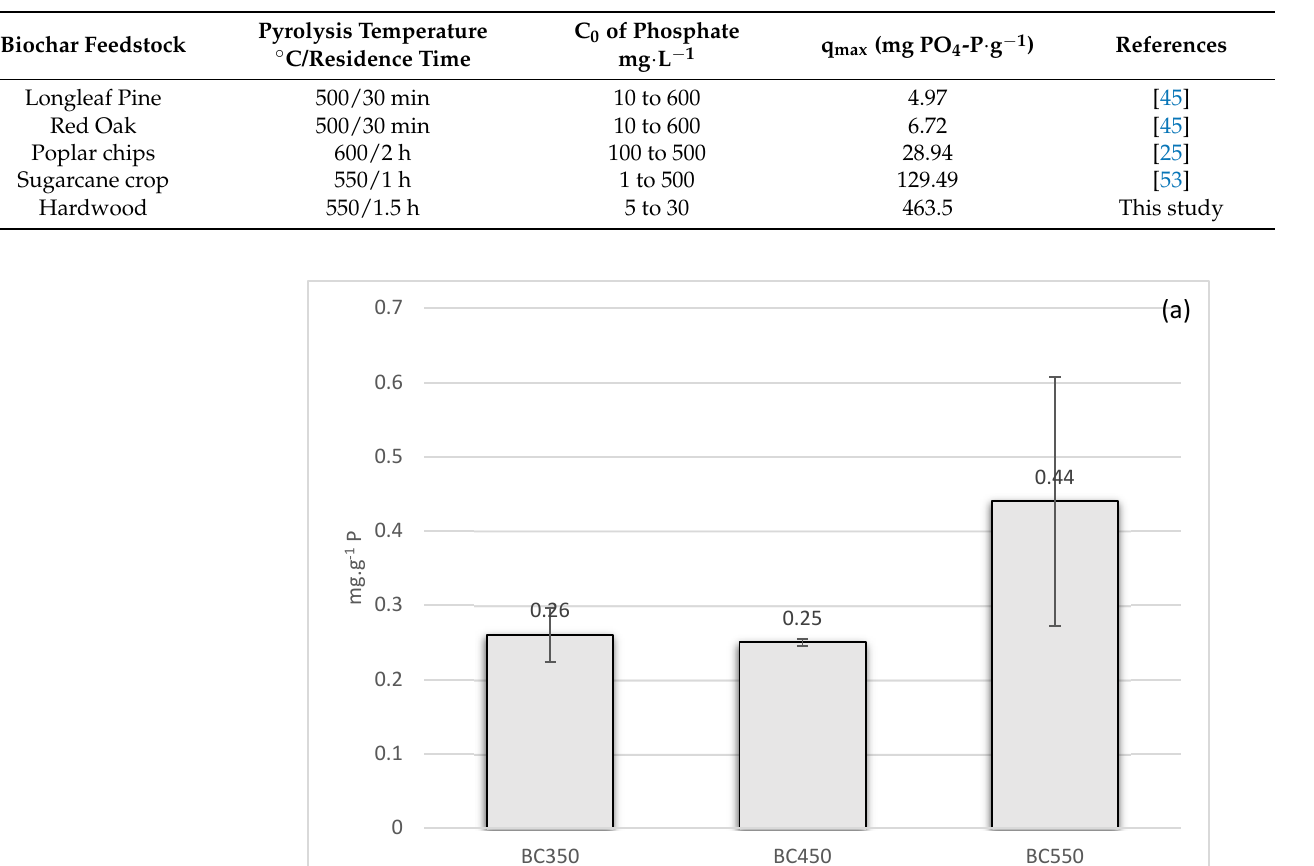
Table 5. Adsorption capacities of PO 4 by other biochar modified with Mg.